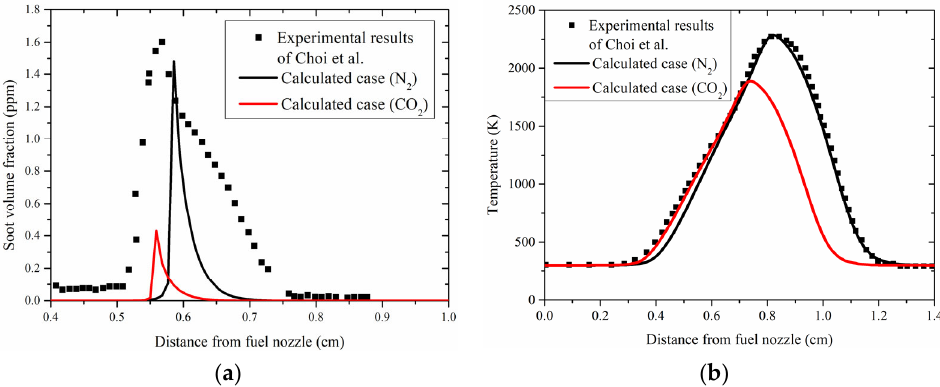
Figure 1. Calculated and experimental SVF profiles ( a ) and temperature profiles ( b ) of SF flames. CO 2 replaces N 2 as dilution progresses, showing significant impacts on the tempera ‐ ture field, soot particle formation or distribution, heat release, and heat radiation. In Fig ‐ ure 1a, the peak value of SVF in the CO 2 /O 2 atmosphere is about 0.43 ppm, only a quarter of the value in the N 2 /O 2 atmosphere. Figure 2a shows the net heat generated by the reac ‐ tion and the temperature distribution in N 2 /O 2 and CO 2 /O 2 atmospheres; the C 2 H 4 /O 2 + CO 2 counterflow diffusion flame has more net heat production from gas ‐ phase reactions than the C 2 H 4 /O 2 + N 2 flame, because CO 2 is not an absolutely inert gas, it participated in